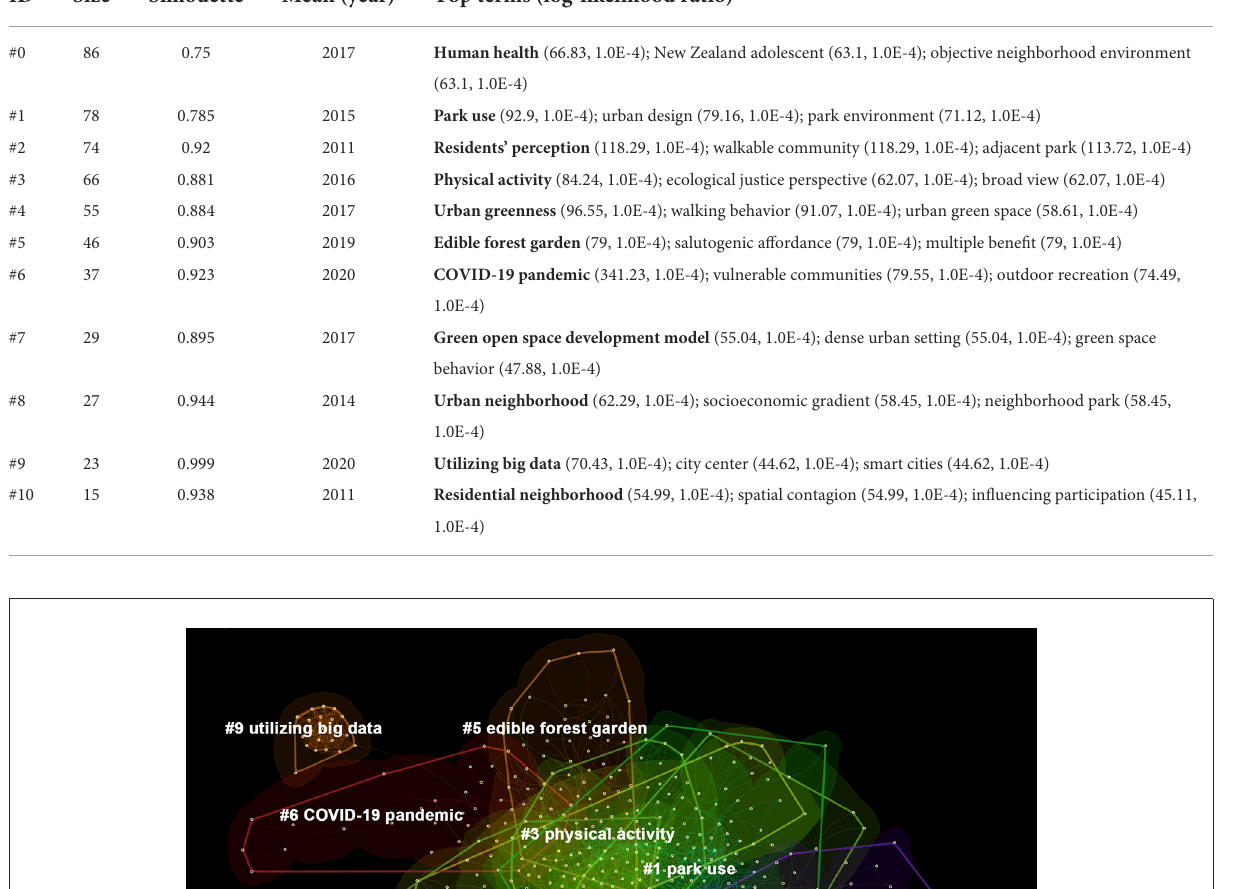
TABLE 3 Summary of 11 clusters.